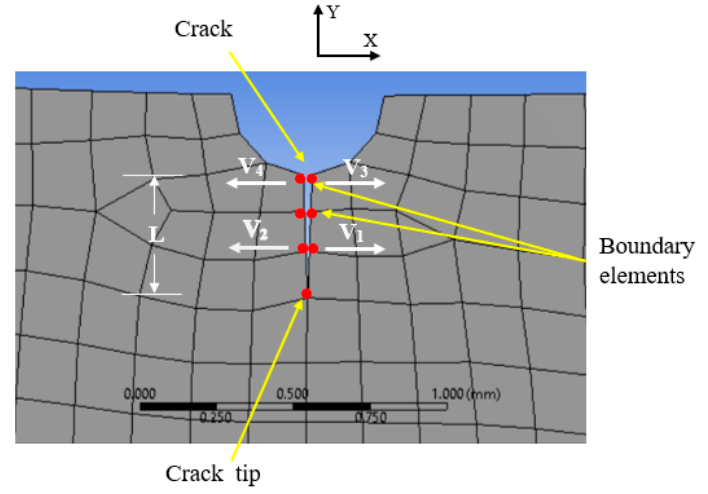
Figure 17. Crack propagation parameters used in numeric simulation.